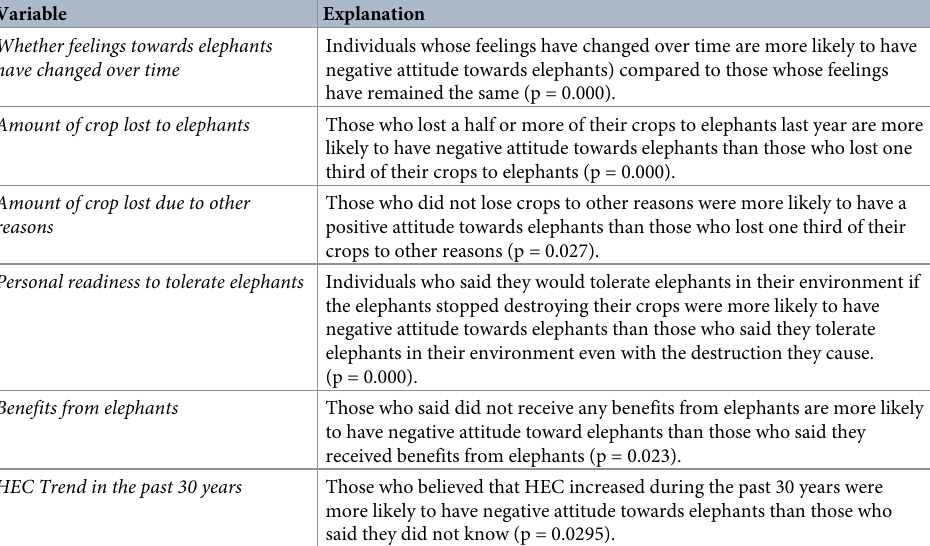
Table 2. Variables influencing variation in attitude in Kilombero, Mvomero and Morogoro Rural